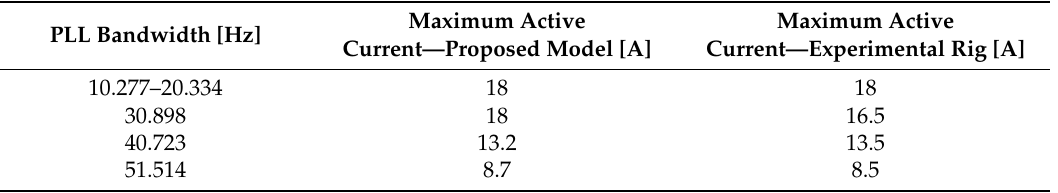
Table 6. Comparison between proposed model and experimental system for SCR = 1.4463.